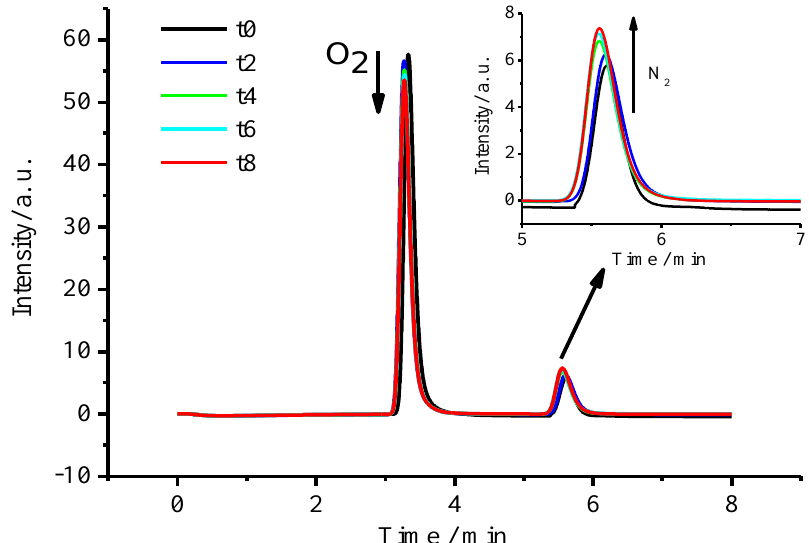
Figure 12. Gas chromatograms during the photocatalytic degradation of ammonia under visible near-infrared light irradiation at t = 0.0, 2.0, 4.0, 6.0 and 8.0 h, respectively.